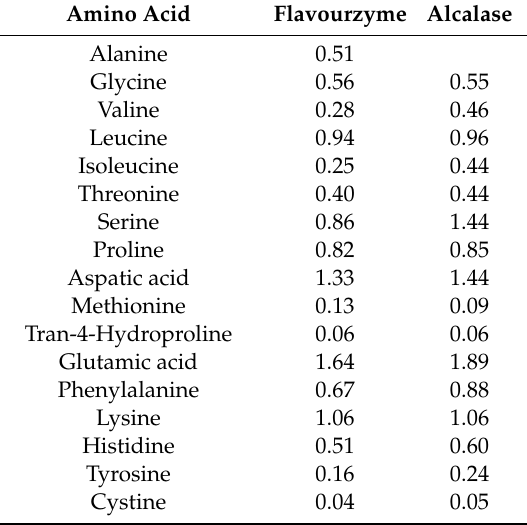
Table 8. The amino acid composition of the hydrolyzed soup collected at the optimal